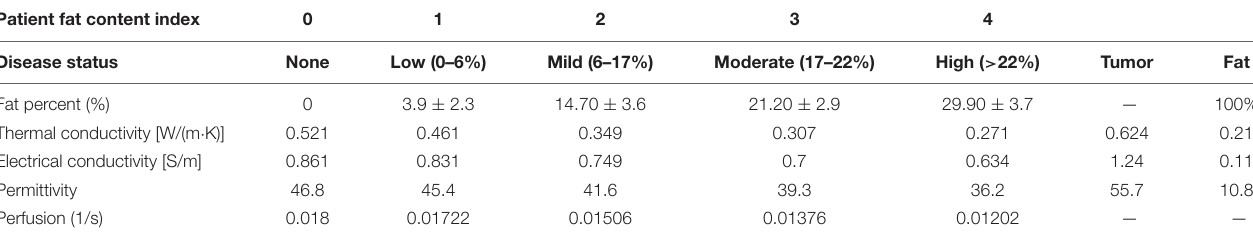
TABLE 2 | Shows the disease state index and the corresponding percent fat derived from the fat quantification imaging data for each